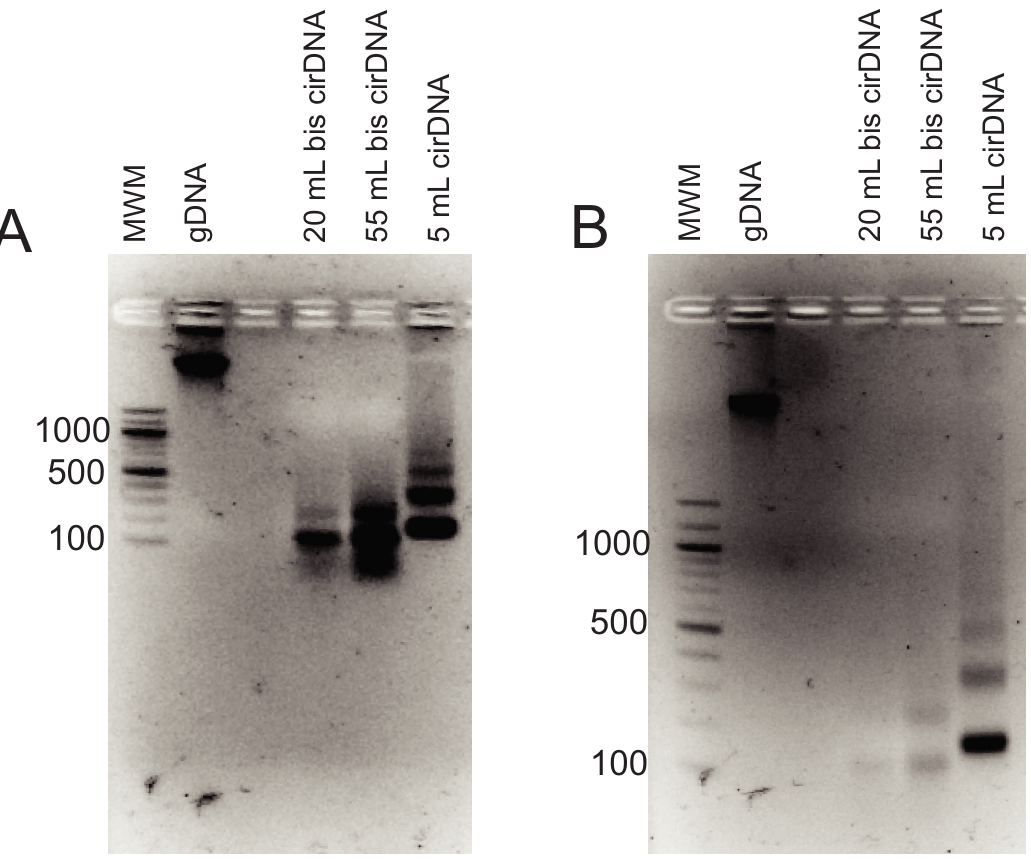
Fig 2. Agarose gel of cirDNA and bis-treated cirDNA following (A) 15 minutes and (B) 40 minutes of electrophoresis. The amount of cirDNA in each lane corresponds to the total cirDNA extracted from the plasma volumes indicated. gDNA–untreated genomic DNA.